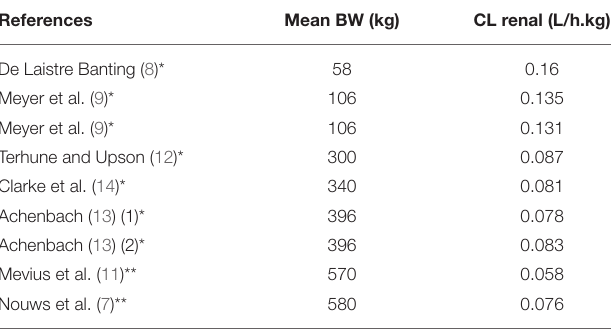
TABLE 3 | References and input data for fitting the renal clearance.